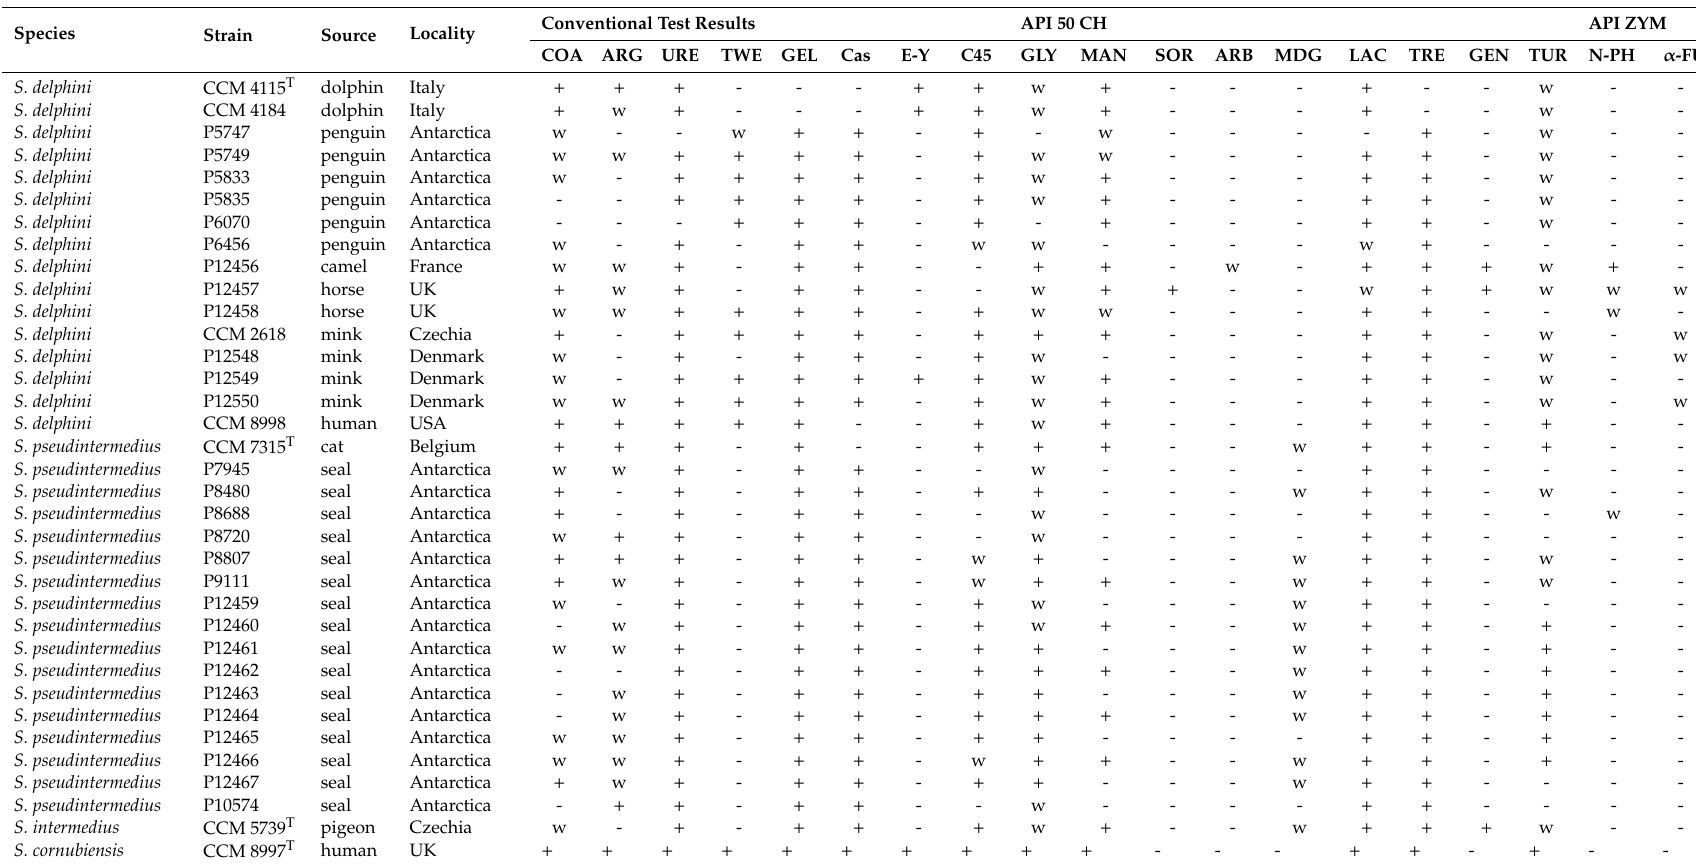
Table 1. Variable phenotypic reactions of Staphylococcus intermedius group strains under